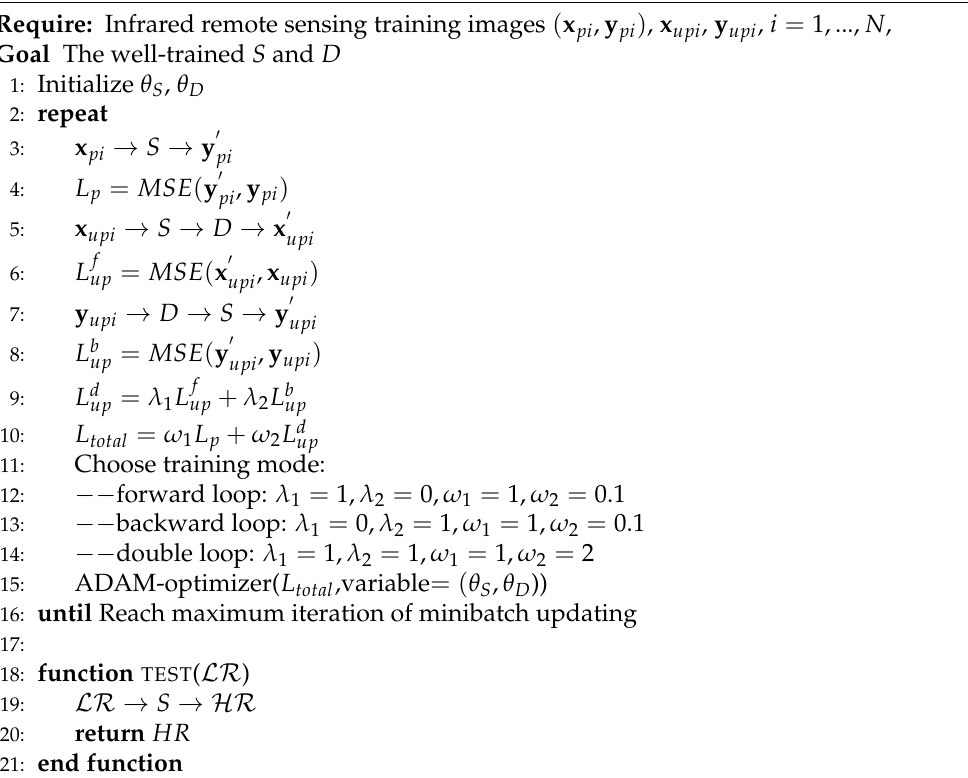
Algorithm 1 Pseudo-codes of our framework in three training